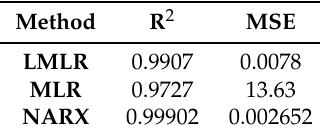
Table 5. Comparison of methods.